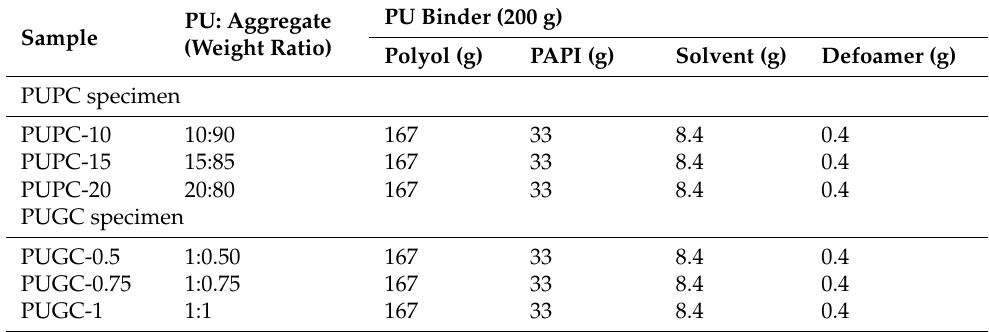
Table 1. Formulation of the PU